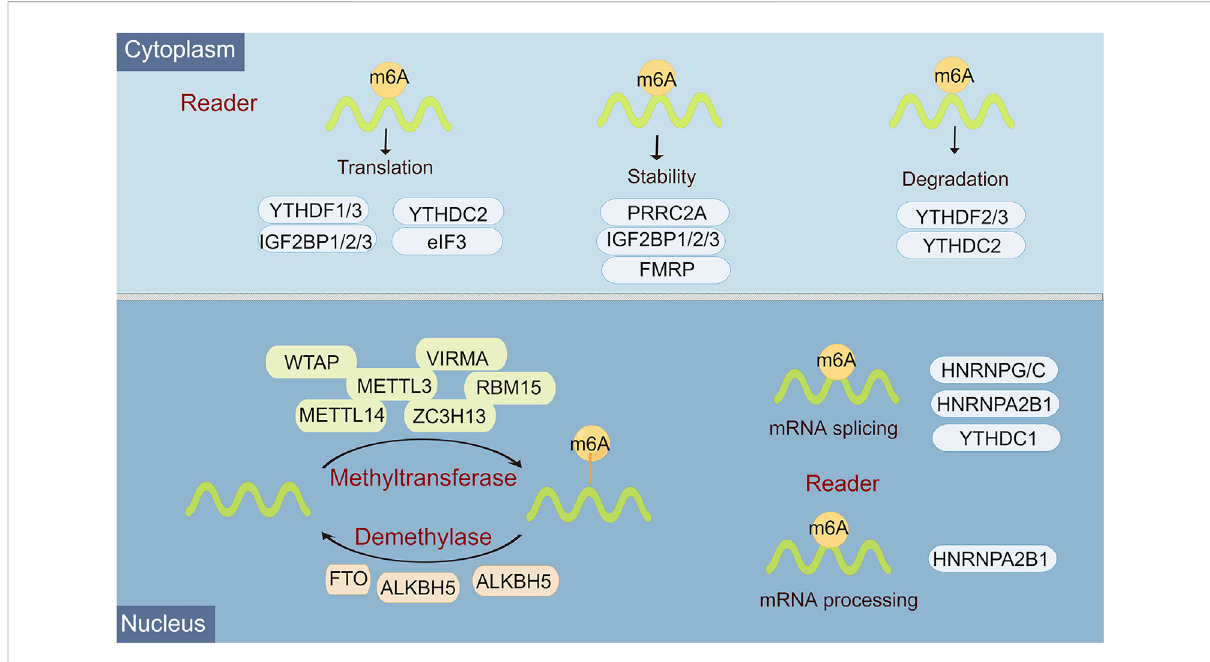
FIGURE 1 Overview of the classi fi cation and molecular mechanisms of m6A methylation. m6A RNA methylation is regulated by 3 different key enzymes, correspondingwriters,erasers,andreaders,whichperformthefunctionsofadding,deleting,orrecognizingm6A,respectively.Theconsequencesof m6A methylation lead to multiple processes in RNA metabolism and expression, including RNA splicing, miRNA processing, nuclear export, translation, stability, and RNA